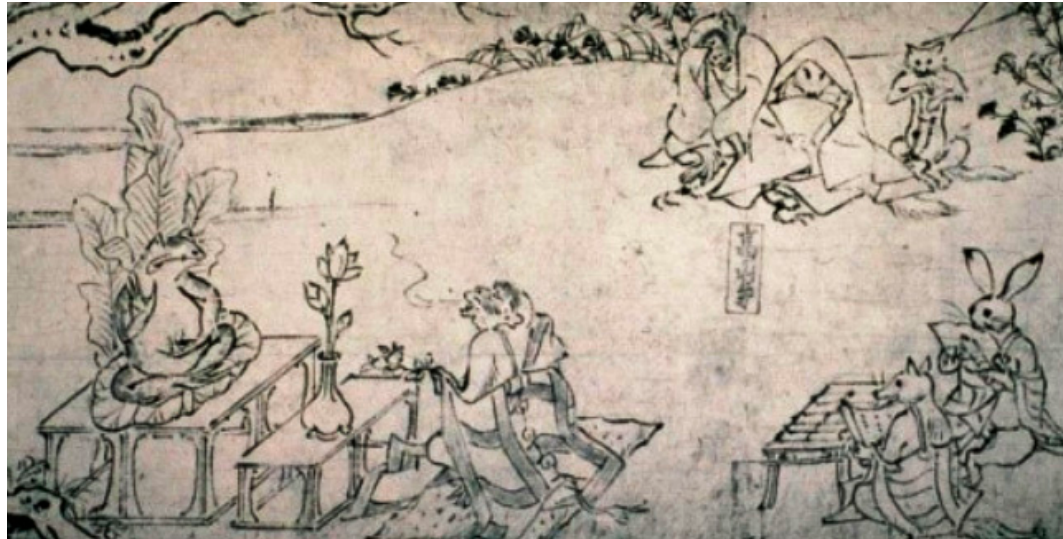
Figure 16. Toha Sojo, Head Priest, Buddha is a frog in full lotus posture. Homo Risibilis. A close-up view of a section.